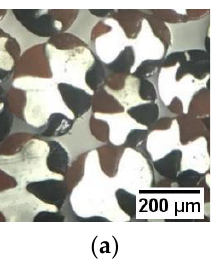
Figure 8. Cross-sections of “fishbone” fibers with different flow ratios. ( a ) The flow ratio is 1:2:1; ( b ) the flow ratio is 3:4:3; ( c ) the flow ratio is 1:1:1; ( d ) the flow ratio is 4:3:4; ( e ) the flow ratio is 2:1:2.